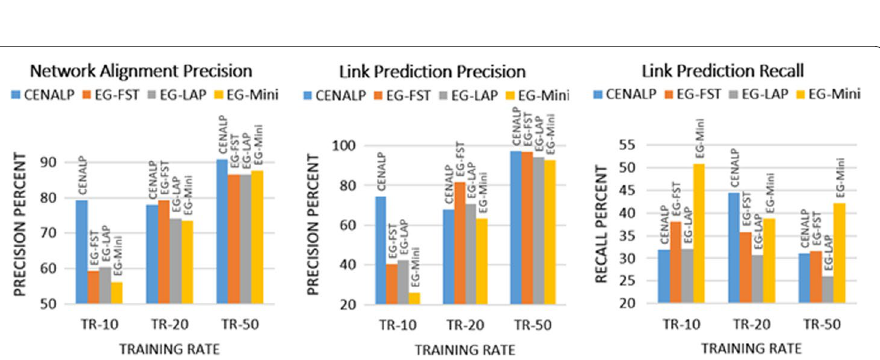
Fig. 6 Network alignment precision and link prediction precision and recall on DBLP on CENALP, EG-FST, EG-LAP and